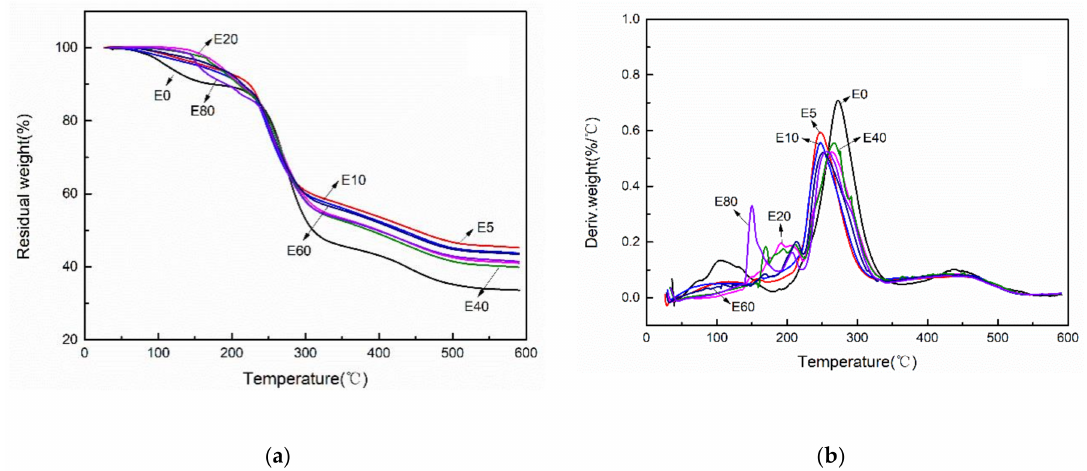
Figure 9. The thermal stabilities of modified hemicellulose films ( a ) TGA curves; ( b ) DTG